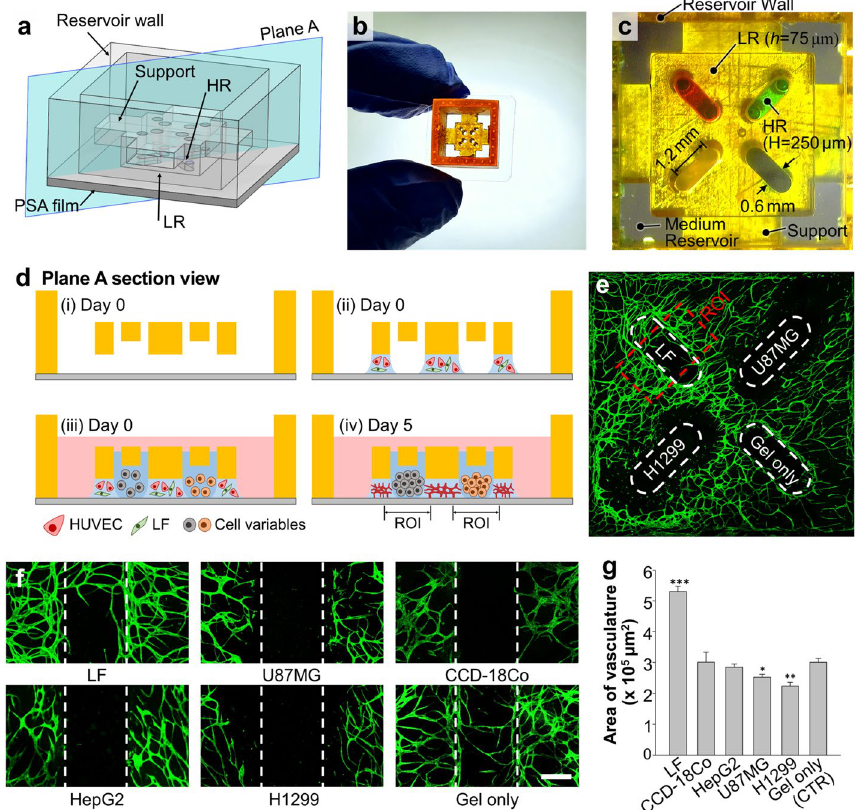
Figure 5. Application of multiple channel rendering for screening vasculogenic capacities of multiple cell types. ( a ) Schematic overview of the device. ( b ) A photo of the device held between two fingers. Edges of a PSA film were not trimmed to highlight that it is bonded to the bottom surface of the 3D printed part. ( c ) Bottom view image of the microfluidic device with four channels surrounded by a square shaped LR (5 mm × 5 mm). ( d ) Schematic diagram of multi-cell co-culture experiment for assessing capabilities to form vascular network. ( e ) Confocal fluorescence image of the vasculogenic co-culture model under the square LR showing CD31 labeled HUVECs with green fluorescence. Red dashed box delineates an example region of interest (ROI) (1 mm × 1.8 mm) centered around the HR, with width equal to three times the HR. ( f ) Representative confocal micrographs of ROIs in channels containing different cell types. Scale bar, 300 μm. ( g ) Plot of average area of vasculature within the ROIs for each cell line obtained from two independent experiments (n = 11 for LF and Gel only, n = 6 for H1299 and U87MG, and n = 5 for CCD-18Co and HepG2). Error bars represent SEM. *** denotes p < 0.001, ** denotes p < 0.01, and * denotes p < 0.05 as measured by one-way ANOVA and comparison against the ’Gel only’ condition with Tukey’s post-hoc